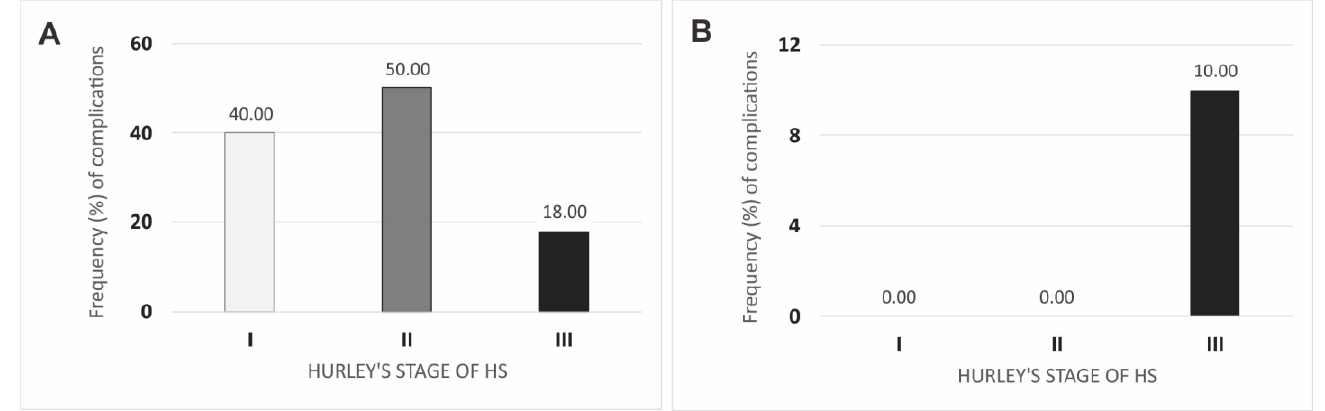
Figure 4. Complications after surgical interventions in regard to Hurley’s stage of Hidradenitis suppurativa in two-week ( A ) and six-month ( B ) follow-up. Legend: HS, hidradenitis suppurativa.